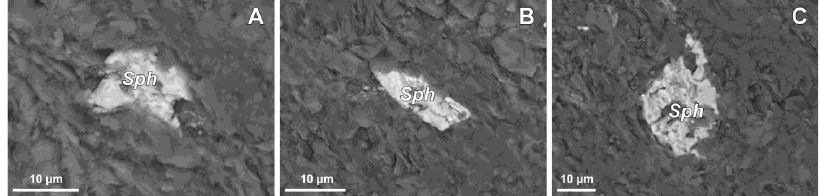
Figure 4. Occurrence of sphalerite (Sph) in black shale from the Priorat DOQ. ( A ) Cluster of small euhedral microcrystals. ( B ) Discrete euhedral sphalerite crystal. ( C ) Partially chemically abraded, equant sphalerite grain.